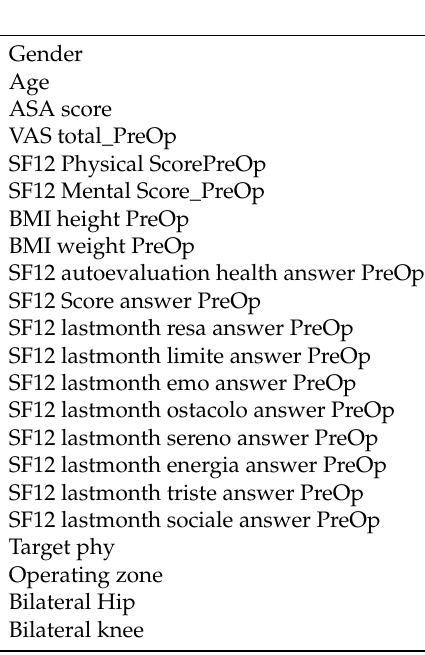
Table 4. Selected